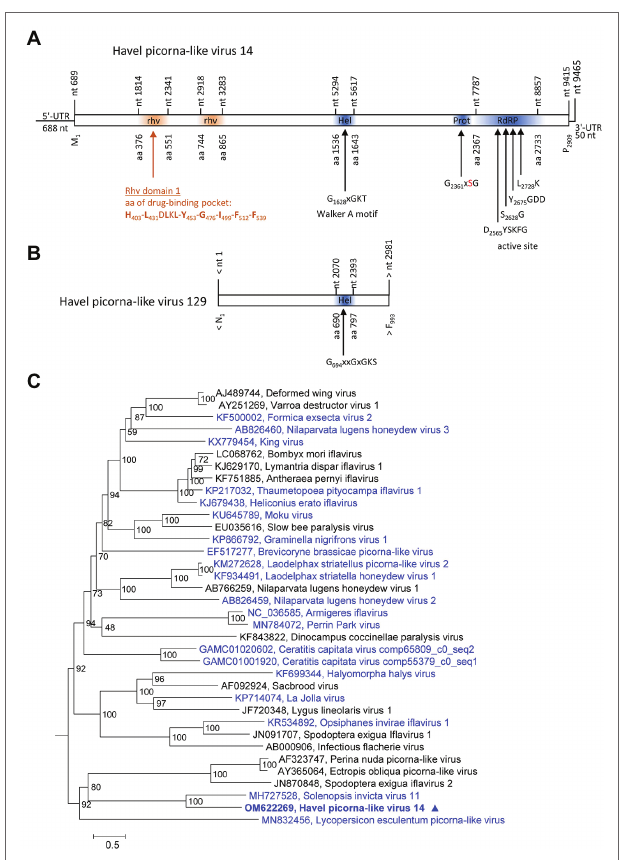
FIGURE 4 | Analysis of Havel picorna-like virus 29. (A) The genome organization corresponds to the picornavirus genome. Conserved domains and sequence motifs were identified by searching the NCBI Conserved Domain Database (https://www.ncbi.nlm.nih.gov/Structure/cdd/wrpsb.cgi). Phylogenetic analyses of the capsid protein-encoding gene region (B) and the proteinase/polymerase gene region (C) of Havel picorna-like virus 29 and 162 picornavirus strains. The tree was inferred with IQ-Tree 2, optimal substitution model: GTR + F + R9 (B) and GTR + F + R8 (C) . The respective sub-families and genera are given to the right. A triangle ( ▲ ) indicates the virus of the present study. Numbers at nodes present bootstrap values obtained after 50,000 ultrafast bootstrap replications. The scale indicates substitutions per site. More details are presented in Supplementary Figures S4A,B . UTR, untranslated region; Hel, helicase; Prot, proteinase; RdRP, polymerase; and rhv, capsid protein with similarity to the rhinovirus capsid protein with jelly roll fold and drug-binding